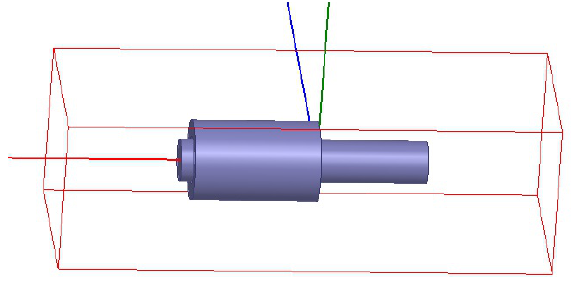
Fig. 4. Three dimensional model of the motor.